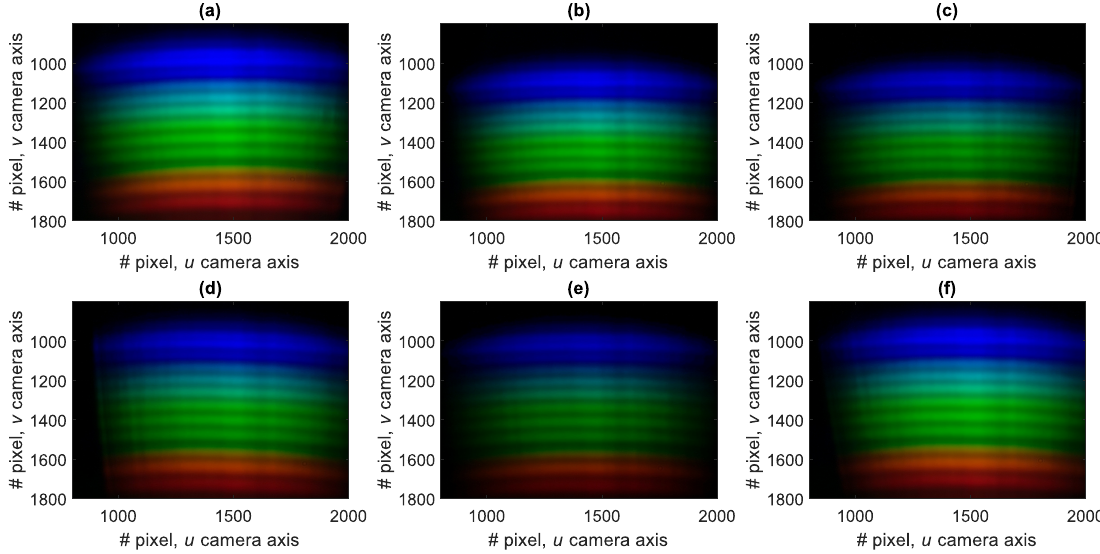
Figure 6. Spectra measured when the fiber and diffraction grating holders were removed from the smartphone and reattached right between the measurements. In ( a – f ) different spectra images, obtained during consecutive measurements, are